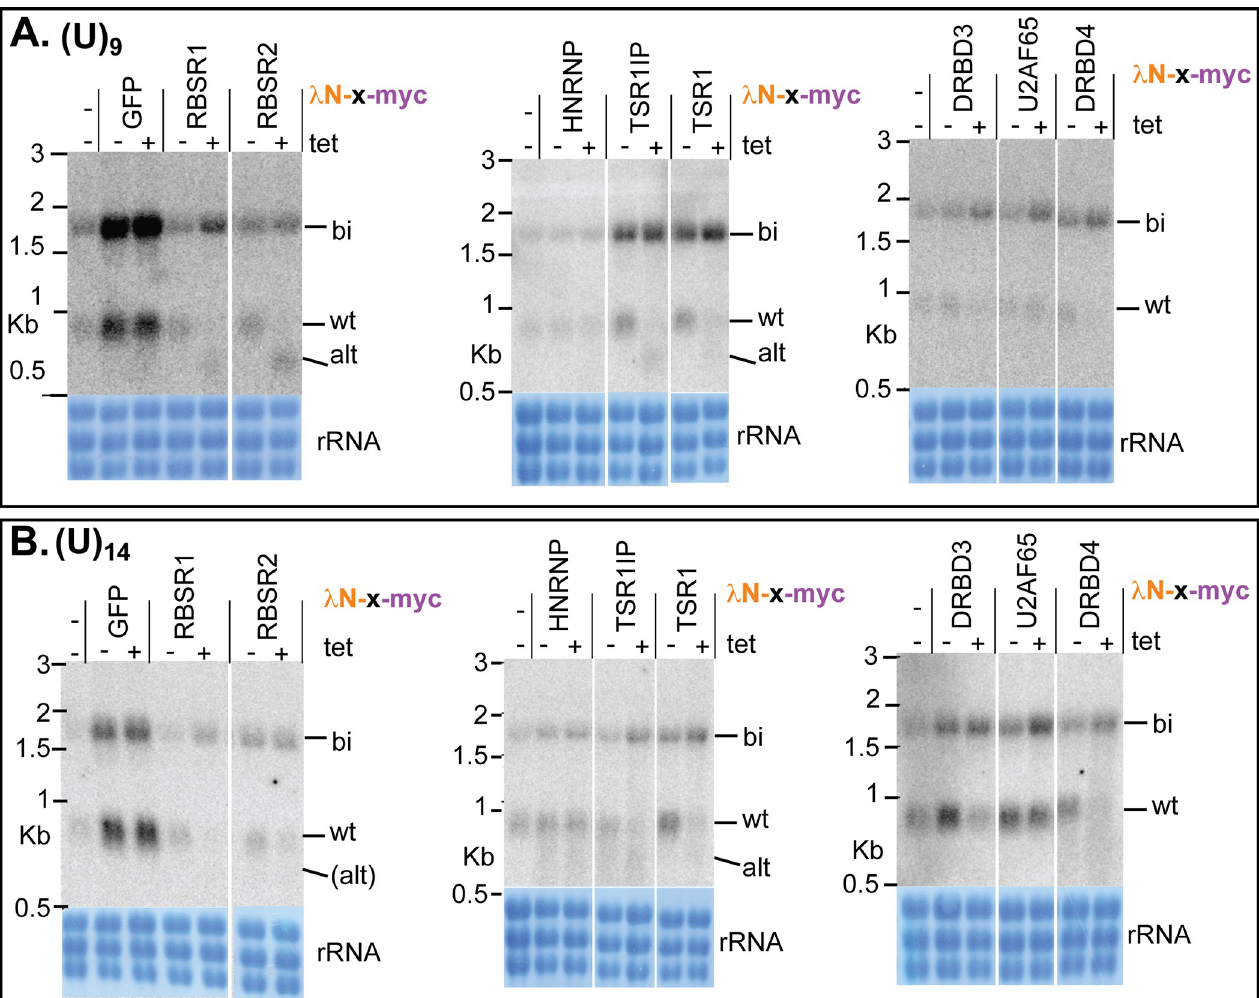
Fig 8. Effects of tethering different proteins to boxB-(U) 9 and boxB-(U) 14 reporters. Northern blots are shown for the BSD mRNAs. Additional clones and replicates are shown in S7–S9 Figs.